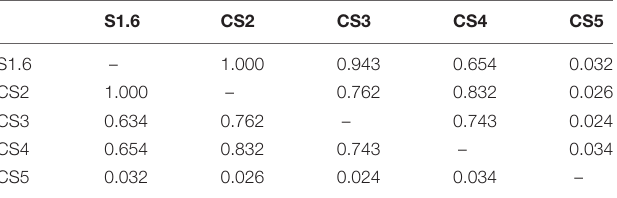
TABLE 7 | The pairwise comparison of gliomas of V APT ( p-